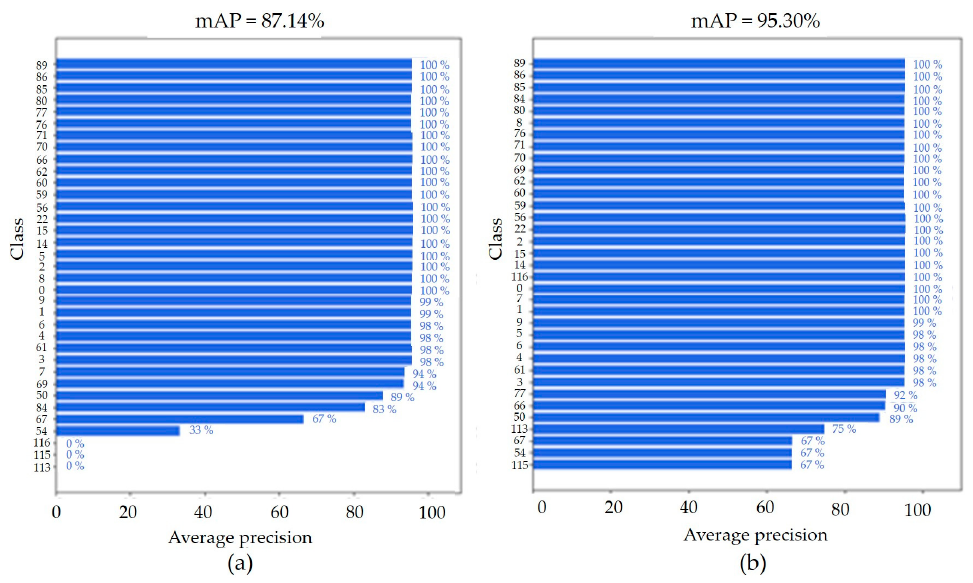
Figure 9. Results of character recognition ( a ) without and ( b ) with artificial license plate generation.